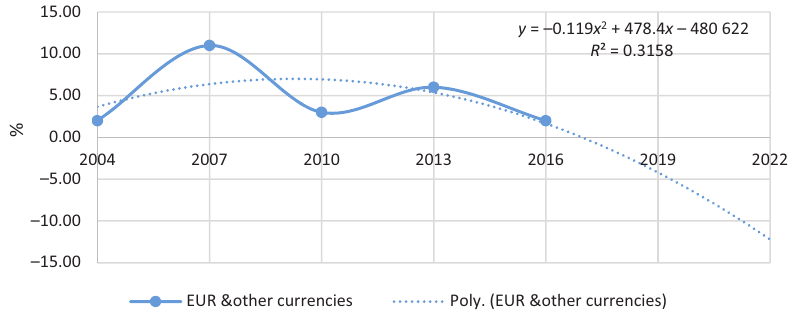
Figure 13. Forecast of the pair EUR/other currencies based on factual data and applying a polynomial function (source: developed by the authors based on LB, 2016, 2018, 2019b; BIS, 2018a,